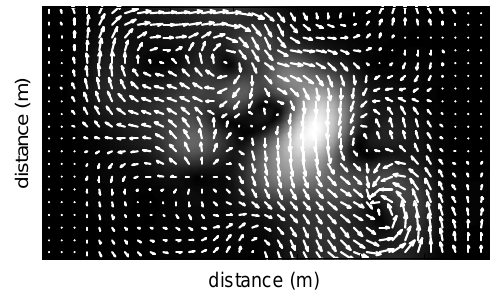
Fig. 8. Structural intensities of a plate with free-free boundary con- ditions obtained by processing the measured vibrating normal ve- locity in wavenumber domain with mirror method being used. The in-plane components ( I x ,I y ) of the structural intensity are repre- (cid:18) sented graphically by arrows. The amplitude of the structural inten- I 2 + I 2 sity x y is represented by the grey scales. The representation dynamic is 20